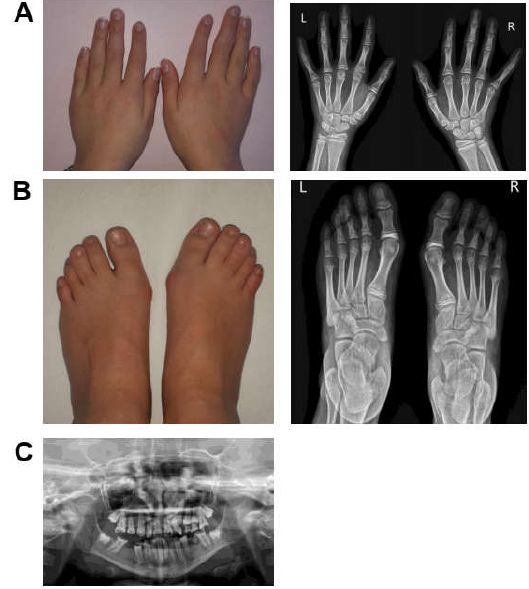
Figure 2. Skeletal anomalies in patient 1. ( A ) Picture and radiograph of the hands. ( B ) Picture and radiograph of the feet. ( C ) Orthopantomography of the teeth. L (left), R